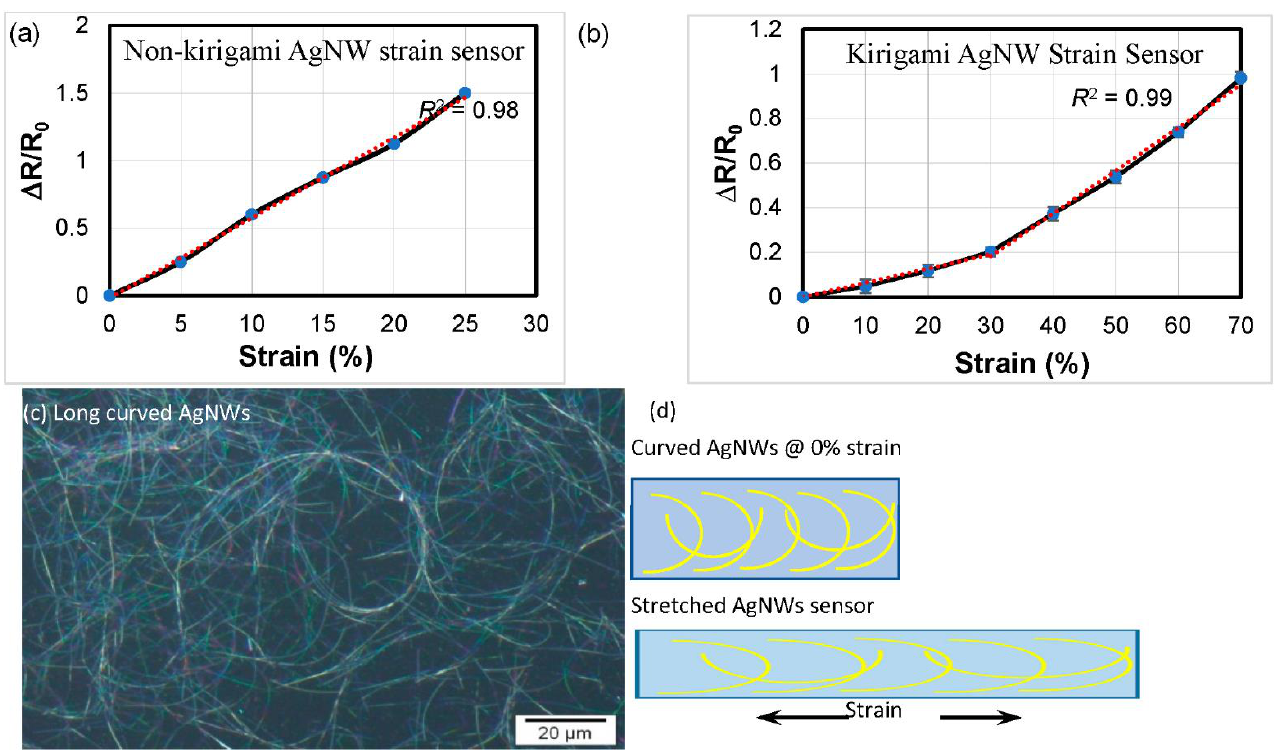
Figure 4. Response of ( a ) non-kirigami and ( b ) kirigami patterned sensors to strains; ( c ) Microscope image of the long curved AgNWs in the strain sensor; ( d ) Illustration of long curved AgNWs with high AR response to the strain.